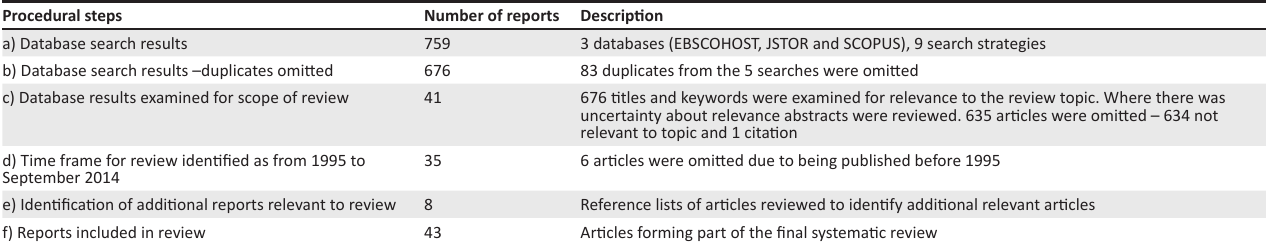
TABLE 1: Description of the search results identifying articles for the narrative